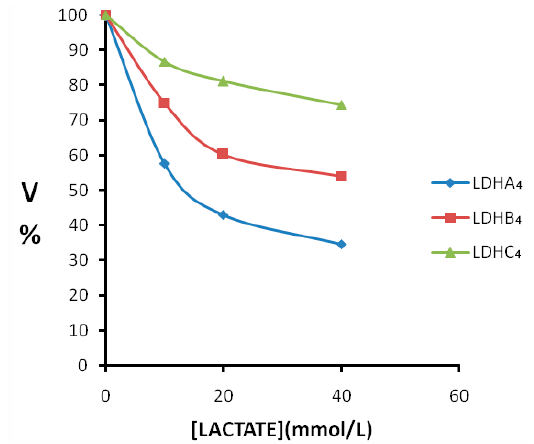
Figure 8. Effect of increasing concentration of lactate on plateau pika LDH isozymes. Pyruvate was used as substrate and lactate as an inhibitor. Velocities were calculated taking the maximum activity without the inhibitor lactate as 100%. Lactate was added at the concentration of 10, 20 and 40 mmol/L. The enzyme reaction velocity of LDH-C 4 was less affected than that of LDH-A 4 and LDH-B 4 when the lactate concentrations were at 0–40 mmol/L.